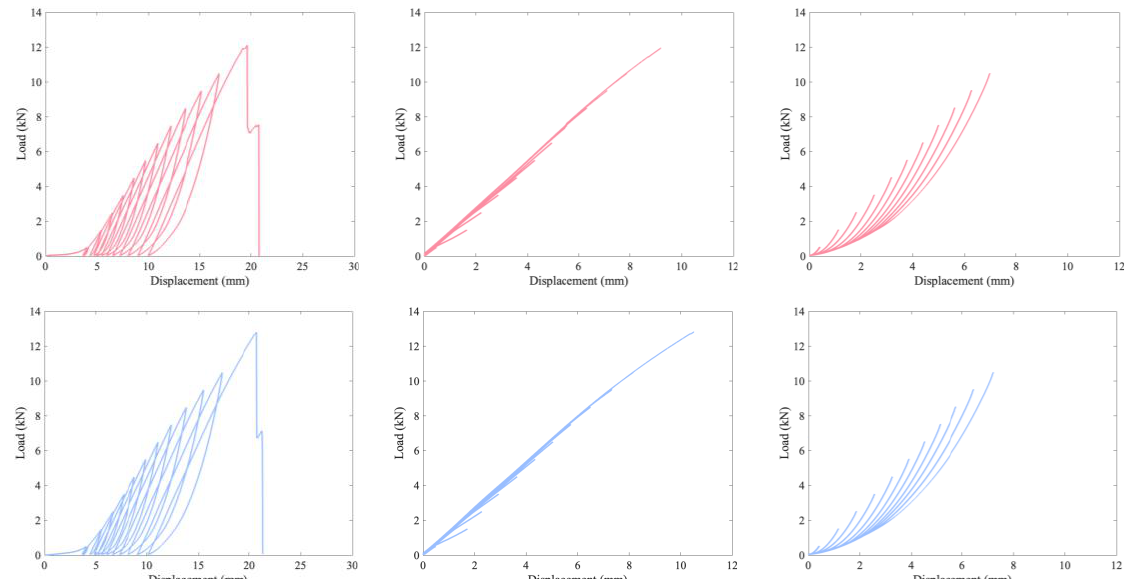
Figure 10. Aged cyclic-tested specimen with 335 d at 70 °C in a desiccator (dry) on top and 336 d at 70 °C and 76% RH on bottom. Left plots the whole loading, middle the superimposed loading portions of the curves, and right the superimposed unloading portions of the curves.